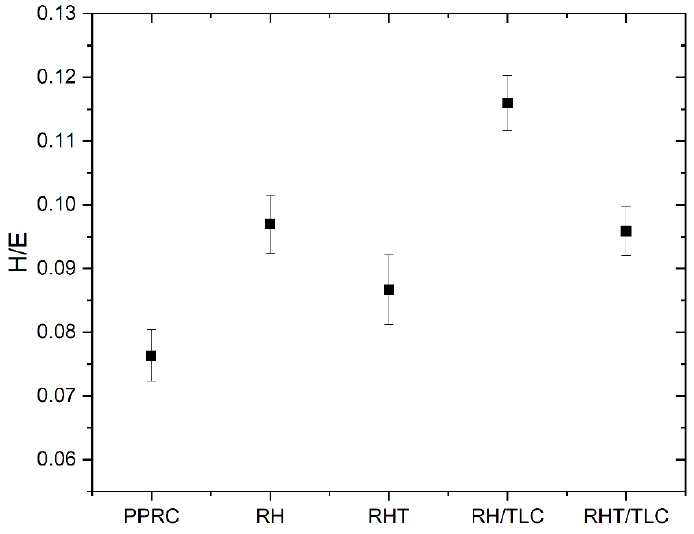
Figure 7. H/E ratio for different